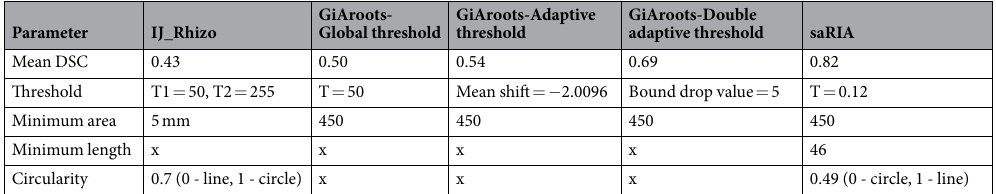
Table 1. Comparison of saRIA image segmentation quality (i.e. mean DSC) and parameters with IJ_Rhizo and